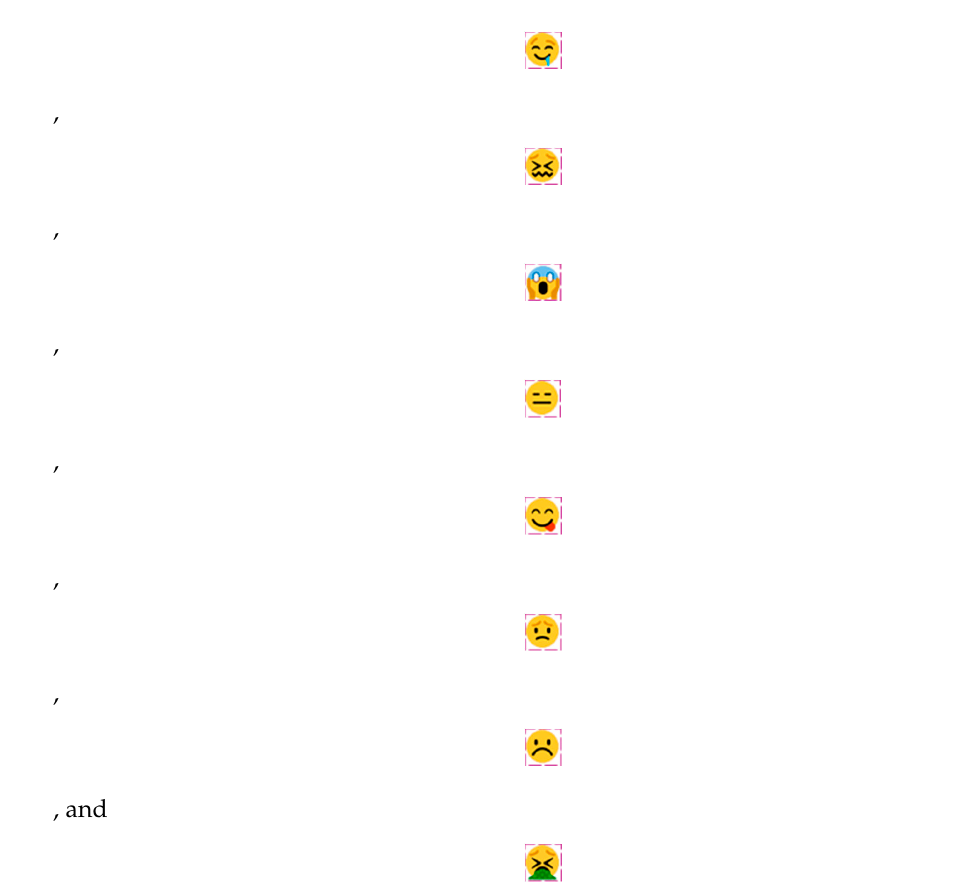
Table 2. Options provided for the check all that apply (CATA) questions for assessment of the coffee pod label samples. Table 3. Attributes obtained from the participants’ video analysis for emotional responses.